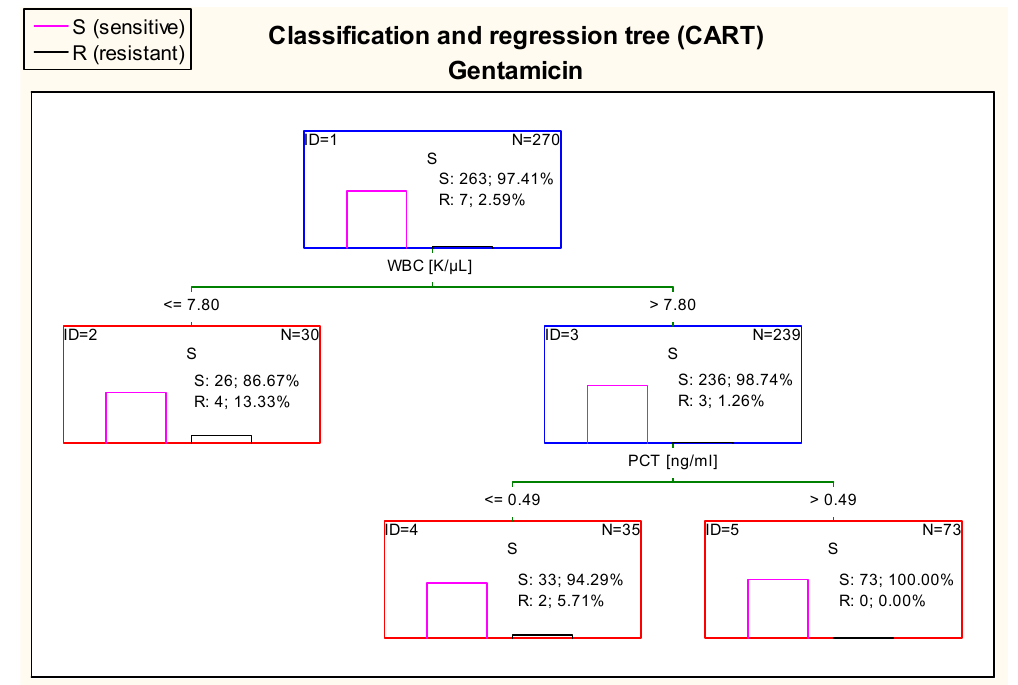
Figure 14. Classification and regression tree (CART) for resistance of Escherichia coli to gentamicin created on the basis of inflammatory markers.